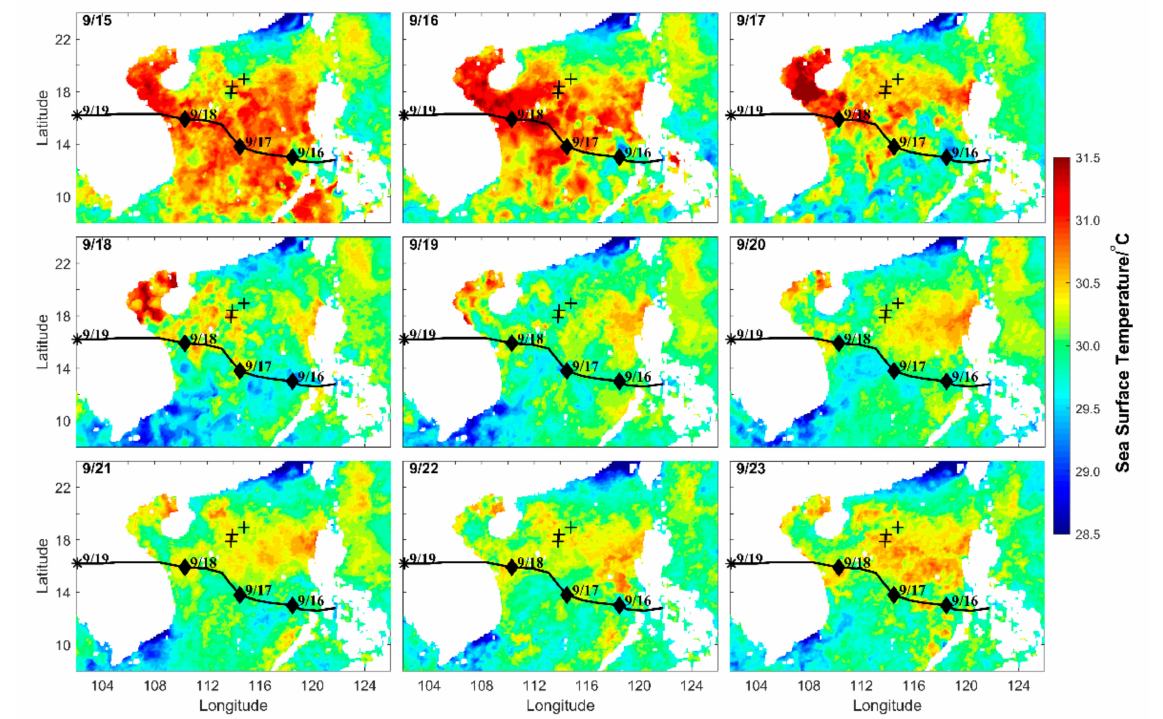
Figure 2. Evolution of SST from September 15 to 23 based on the Remote Sensing System (RSS) dataset. The black line and diamonds show the track and center of Noul. The black plus signs denote the three moorings.